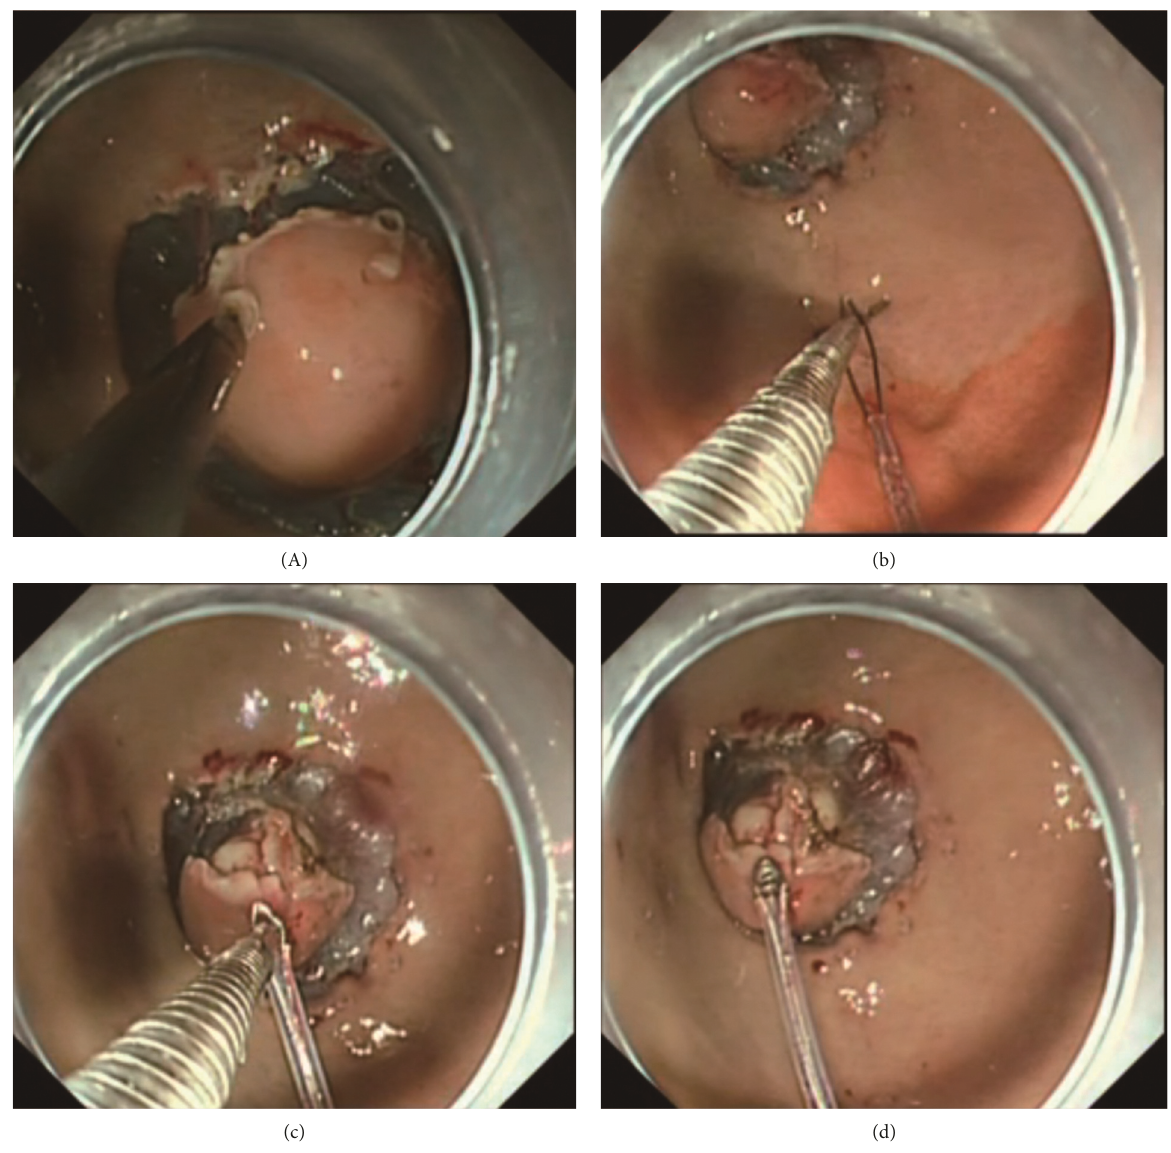
Figure 2: ESD combined with CSM-PLTprocedure. (A) (a) Circumferential incision; (b) moving the hemoclip toward the prelooped snare; (c) releasing hemoclip and tightening the snare; (d) applying an appropriate tension to the tumor through the